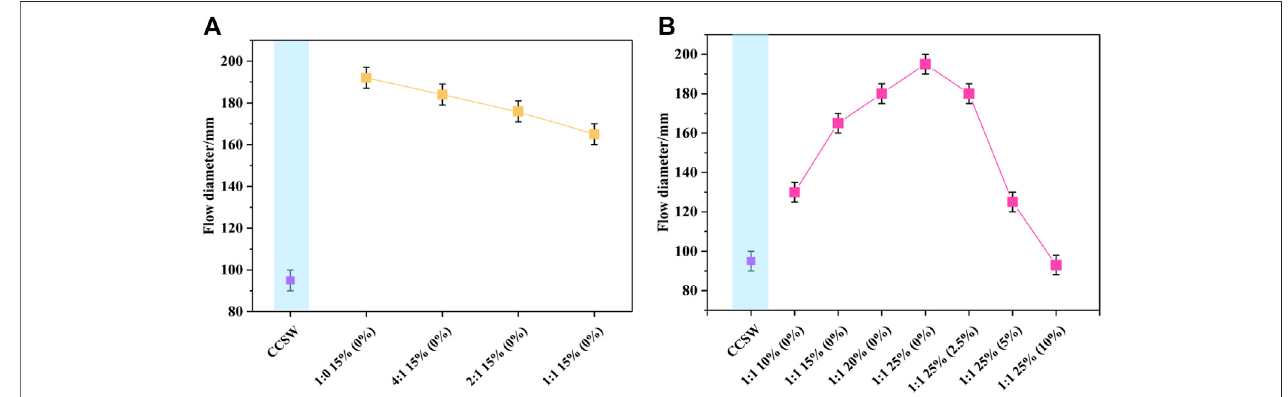
FIGURE 4 | Flowability of the CCSW and GCSW ( A : in fl uence of slag; B : in fl uence of activator and silica fume).